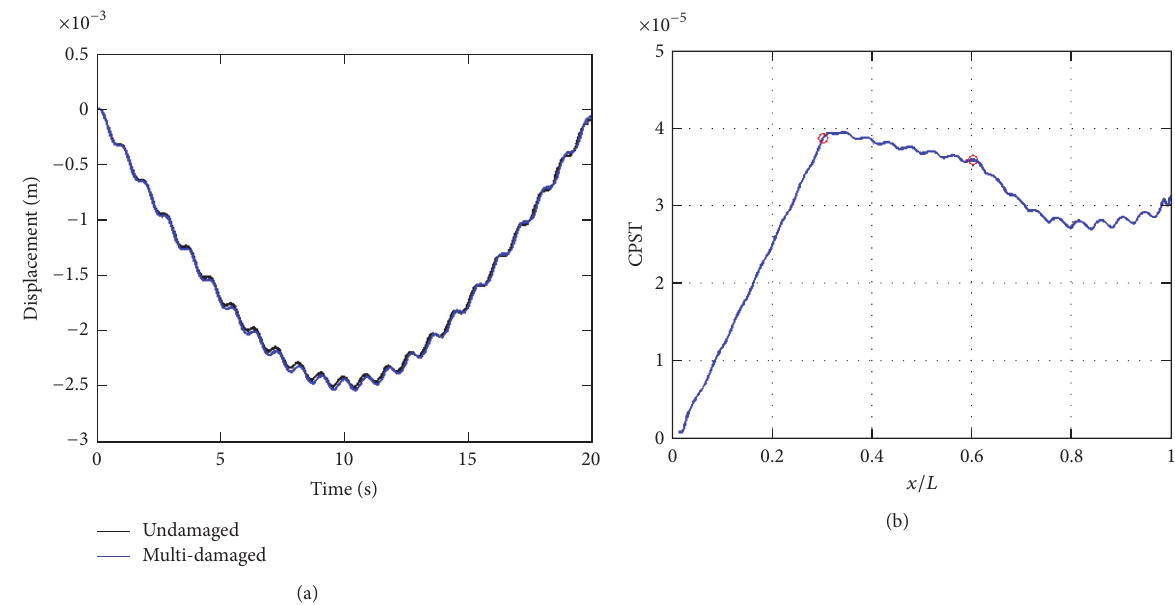
Figure 27: Multidamaged results: (a) is displacement responses and (b) is the CPST